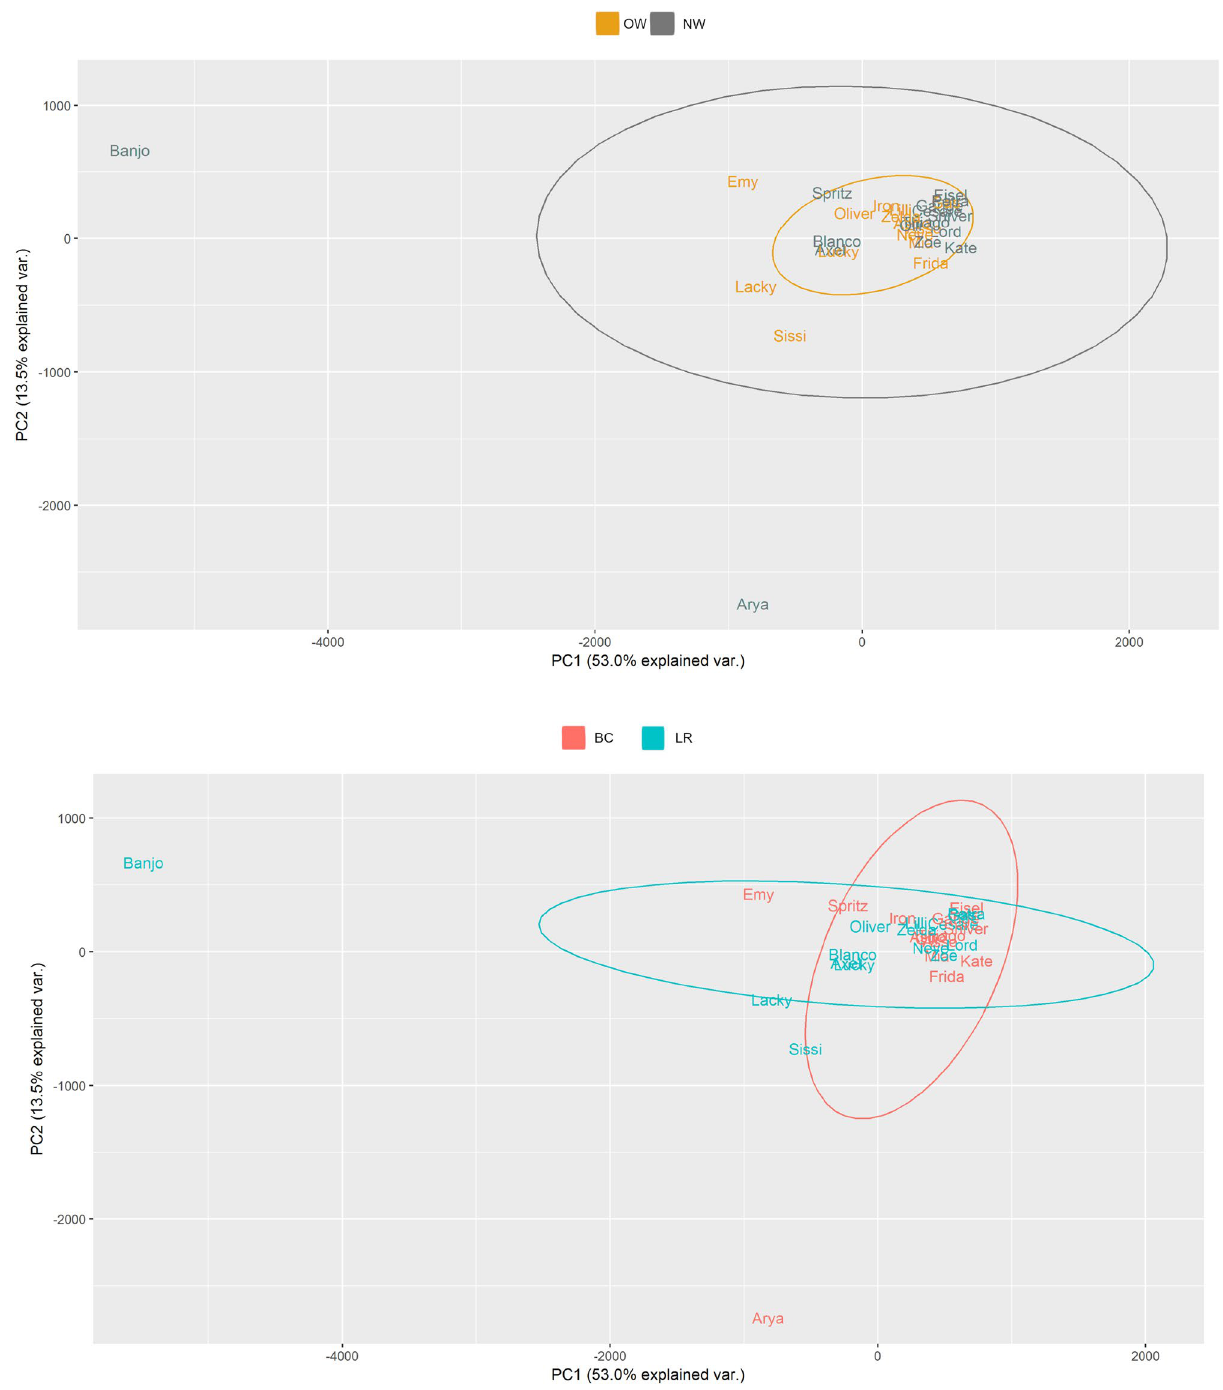
Figure 3. Principal component analysis (PCA) on Bray–Curtis dissimilarity at ASV; the colour scheme reflects ( a ) condition (lean, NW, n = 15; overweight, OW, n = 14) or ( b ) breed (Labrador Retrievers, LR, n = 15; Border Collies, BC, n = 14). Dogs’ names were used to distinguish the analysed samples. Neither plot showed a clustering between both groups. This figure was created using R version 3.4.3 (https:// www.r- proje ct.